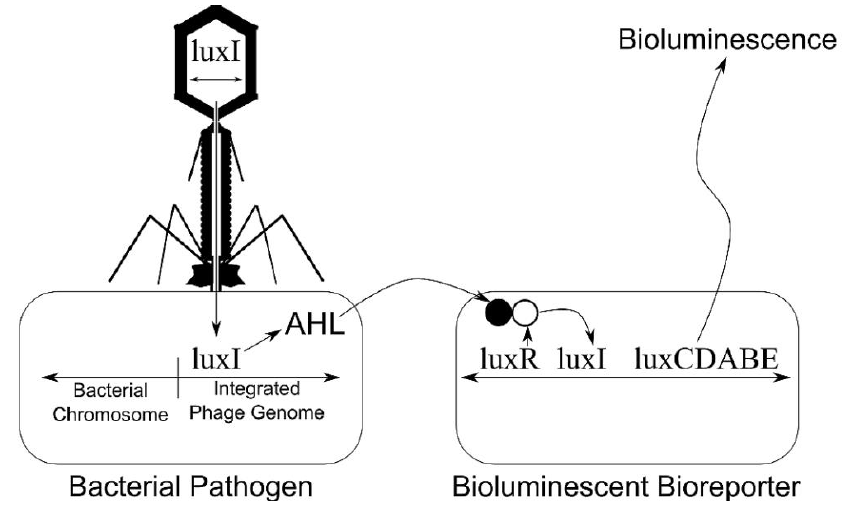
Figure 8. The principle of bacterial bioluminescence